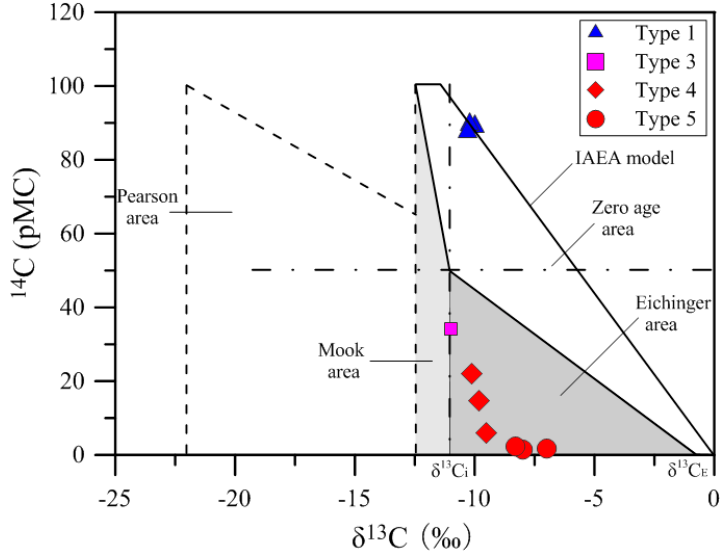
Figure 11. A plot of 14 C versus δ 13 C (Han and Plummer diagram) for the groundwater samples in the